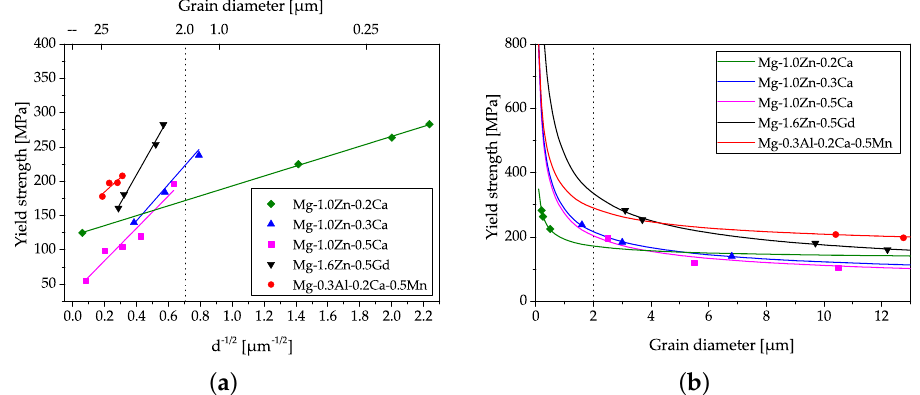
Figure 3. Hall–Petch slopes of multiple Mg lean alloys ( a ), as well as the calculated rise in YS values with decreasing grain size in ( b ). Experimental data were taken from refs. [28,40–43], and further information is given in